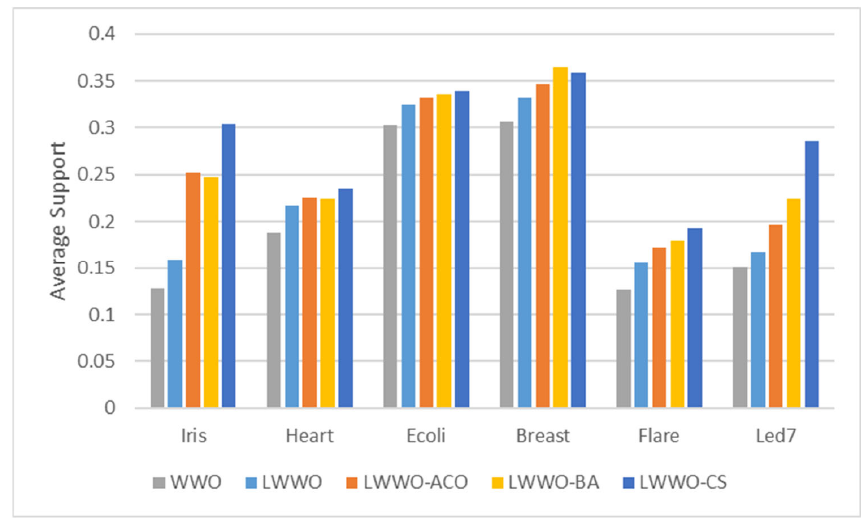
Figure 7. Comparison of average support.